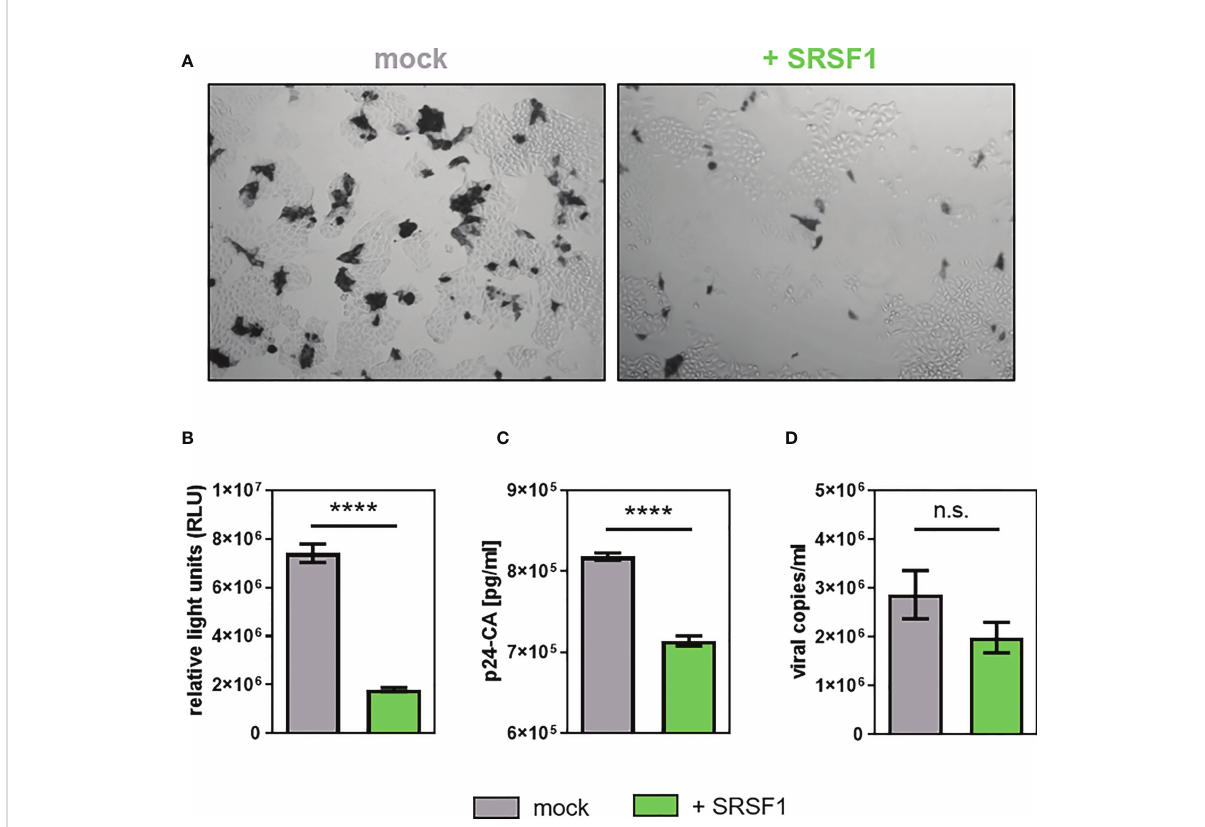
FIGURE 10 Overexpression of SRSF1 affects HIV-1 infectivity and viral particle production. HEK293T cells were co-transfected with a plasmid coding for the proviral clone NL4-3 PI952 (pNL4-3 PI952) (371) and a plasmid coding for FLAG-tagged SRSF1 (pcDNA-FLAG-SF2) or an empty vector [pcDNA3.1(+)] as mock control. (A, B) Seventy-two hours post-transfection, the cell culture supernatant was used to determine viral infectious titers using TZM-bl reporter cells. (A) X-Gal staining of TZM-bl cells incubated with the cellular supernatant. (B) Measurement of luciferase activity. (C) Viral RNA extracted from the supernatant was subjected to RT-qPCR to quantify absolute expression levels of exon 7-containing transcripts (total viral mRNA). (D) p24-CA ELISA was performed to determine viral particle production. Statistical signi fi cance was calculated using unpaired two-tailed t -tests (**** p < 0.0001 and ns, not signi fi cant). Mean ( ± SEM) of n = 4 biological replicates is depicted for (B – D)